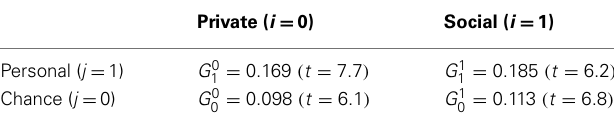
Table 1 | Counterfactual comparisons in behavioral